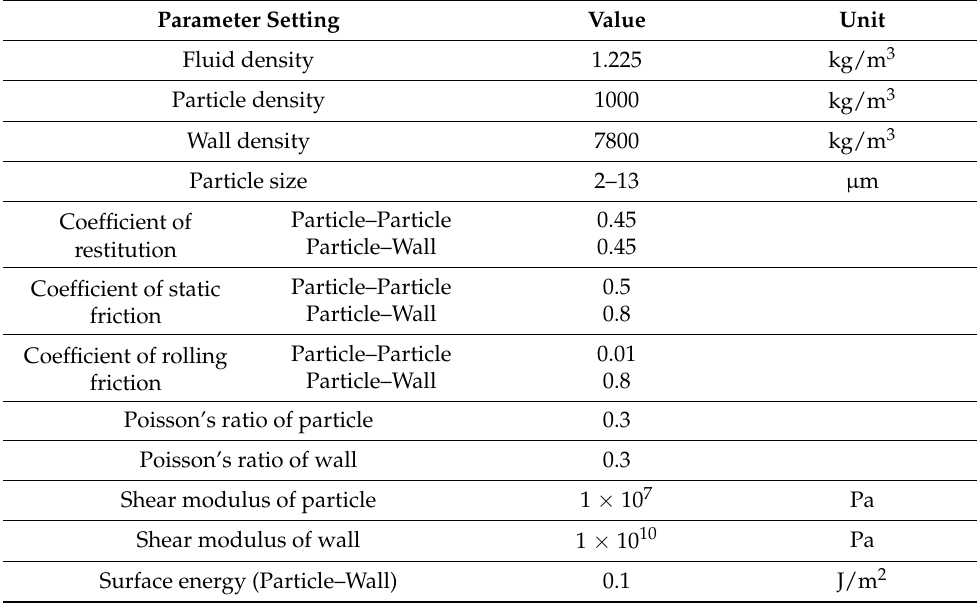
Table 1. Calculation conditions for CFD-DEM simulations.